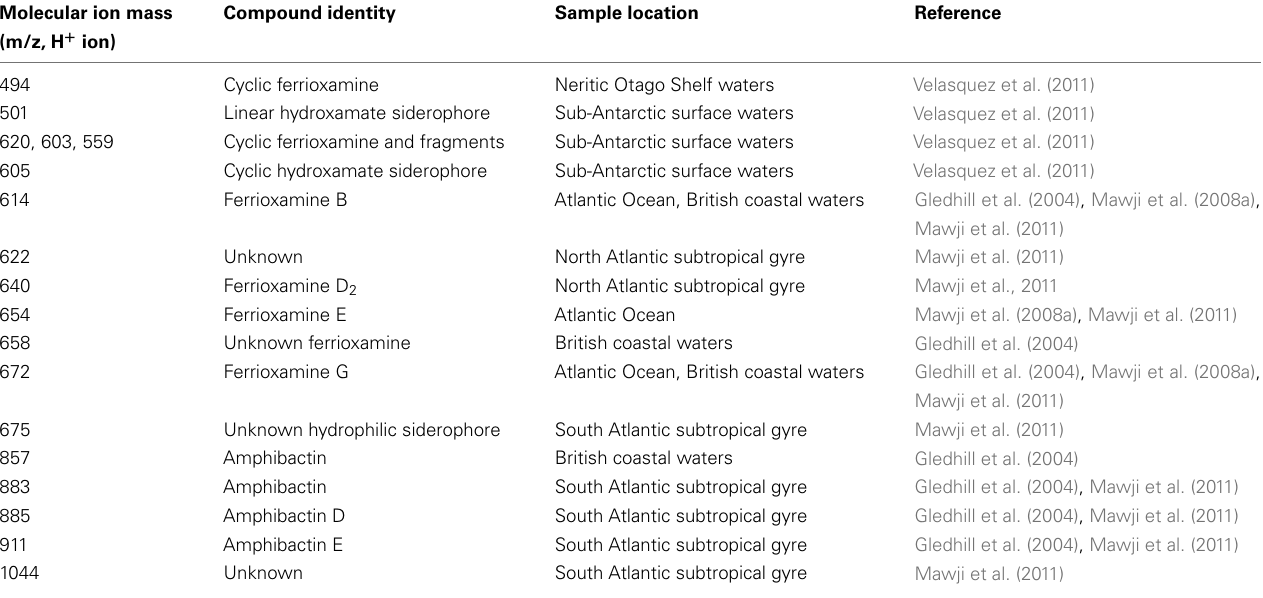
Table 2 | Siderophores identified in seawater or natural seawater incubations by high performance liquid chromatography – electrospray ionization mass